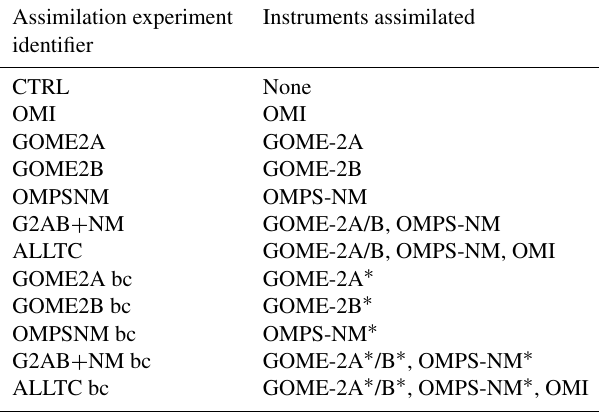
Table 5. List of assimilation experiments and their corresponding shorthand identifiers. In the second column, an asterisk (*) next to an instrument denotes that the bias-corrected observations (using the colocation method of Sect. 4.1) were